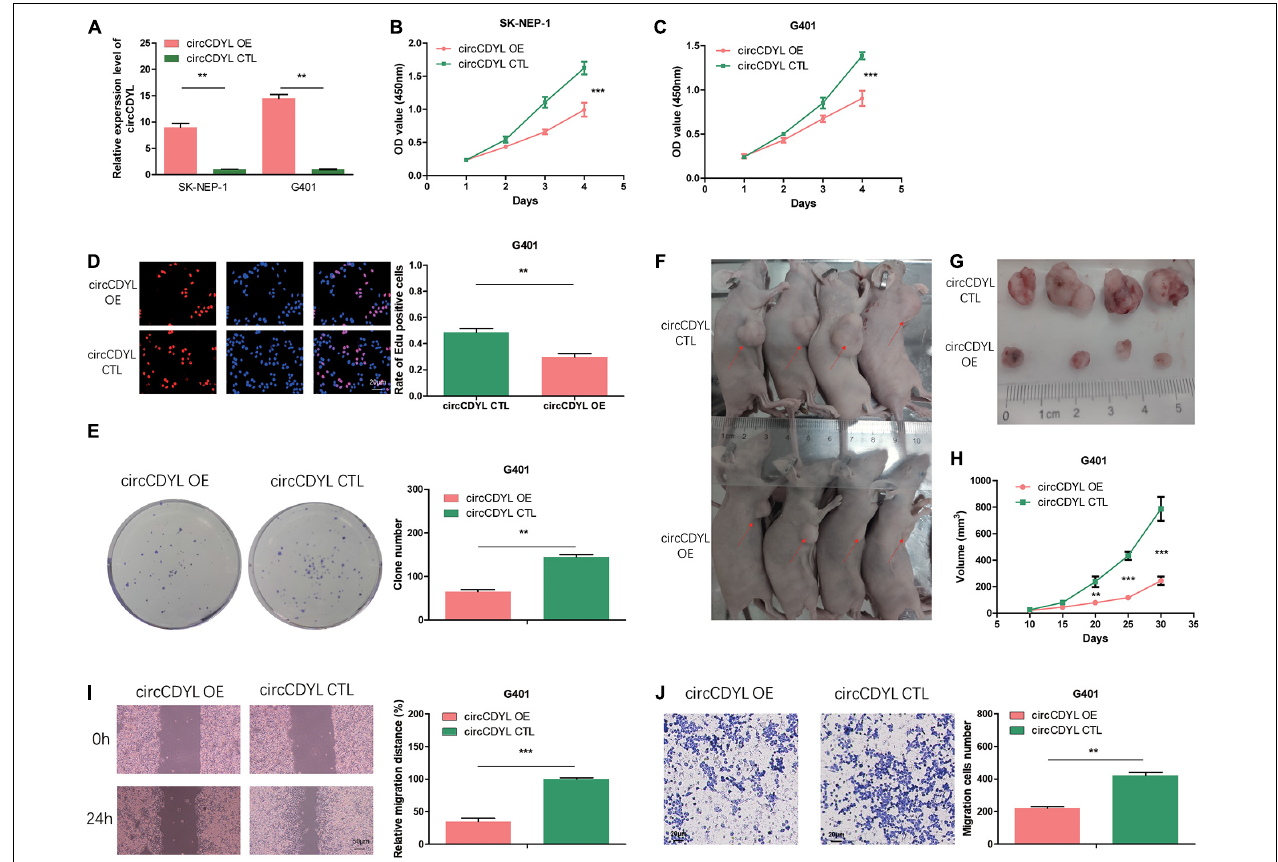
FIGURE 2 | Overexpression of circCDYL suppresses proliferation, migration, and invasion in WT cells. (A) The expression levels of circCDYL were assessed using qRT-PCR in SK-NEP-1 and G401 cells after transfection with adenovirus carrying circCDYL. (B,C) The proliferation of SK-NEP-1 and G401 cells by the CCK-8 method. (D,E) The proliferation of G401 cells by EdU and colony formation assays. (F,G) Xenograft tumors in a mouse model of Wilms’ tumor. (H) Tumor volumes of the circCDYL overexpression and control treatment groups. (I,J) The migration and invasion of G401 cells by wound healing assays and transwell assays. Student’s t -test with two biologically dependent or independent replicates was used to determine statistical significance; *** P < 0.001, ** P < 0.01, * P <